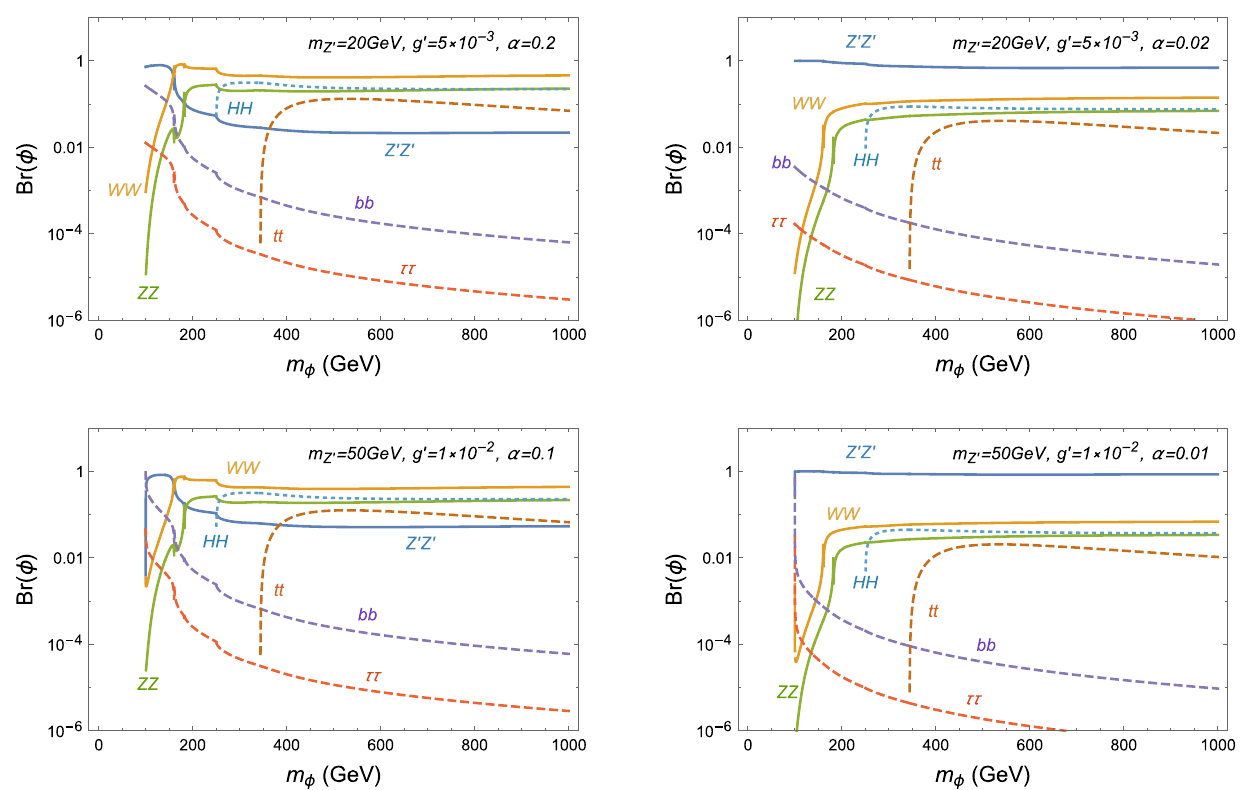
Fig. 2 The branching ratios of φ decays as a function of m φ . The final states are indicated near each curves